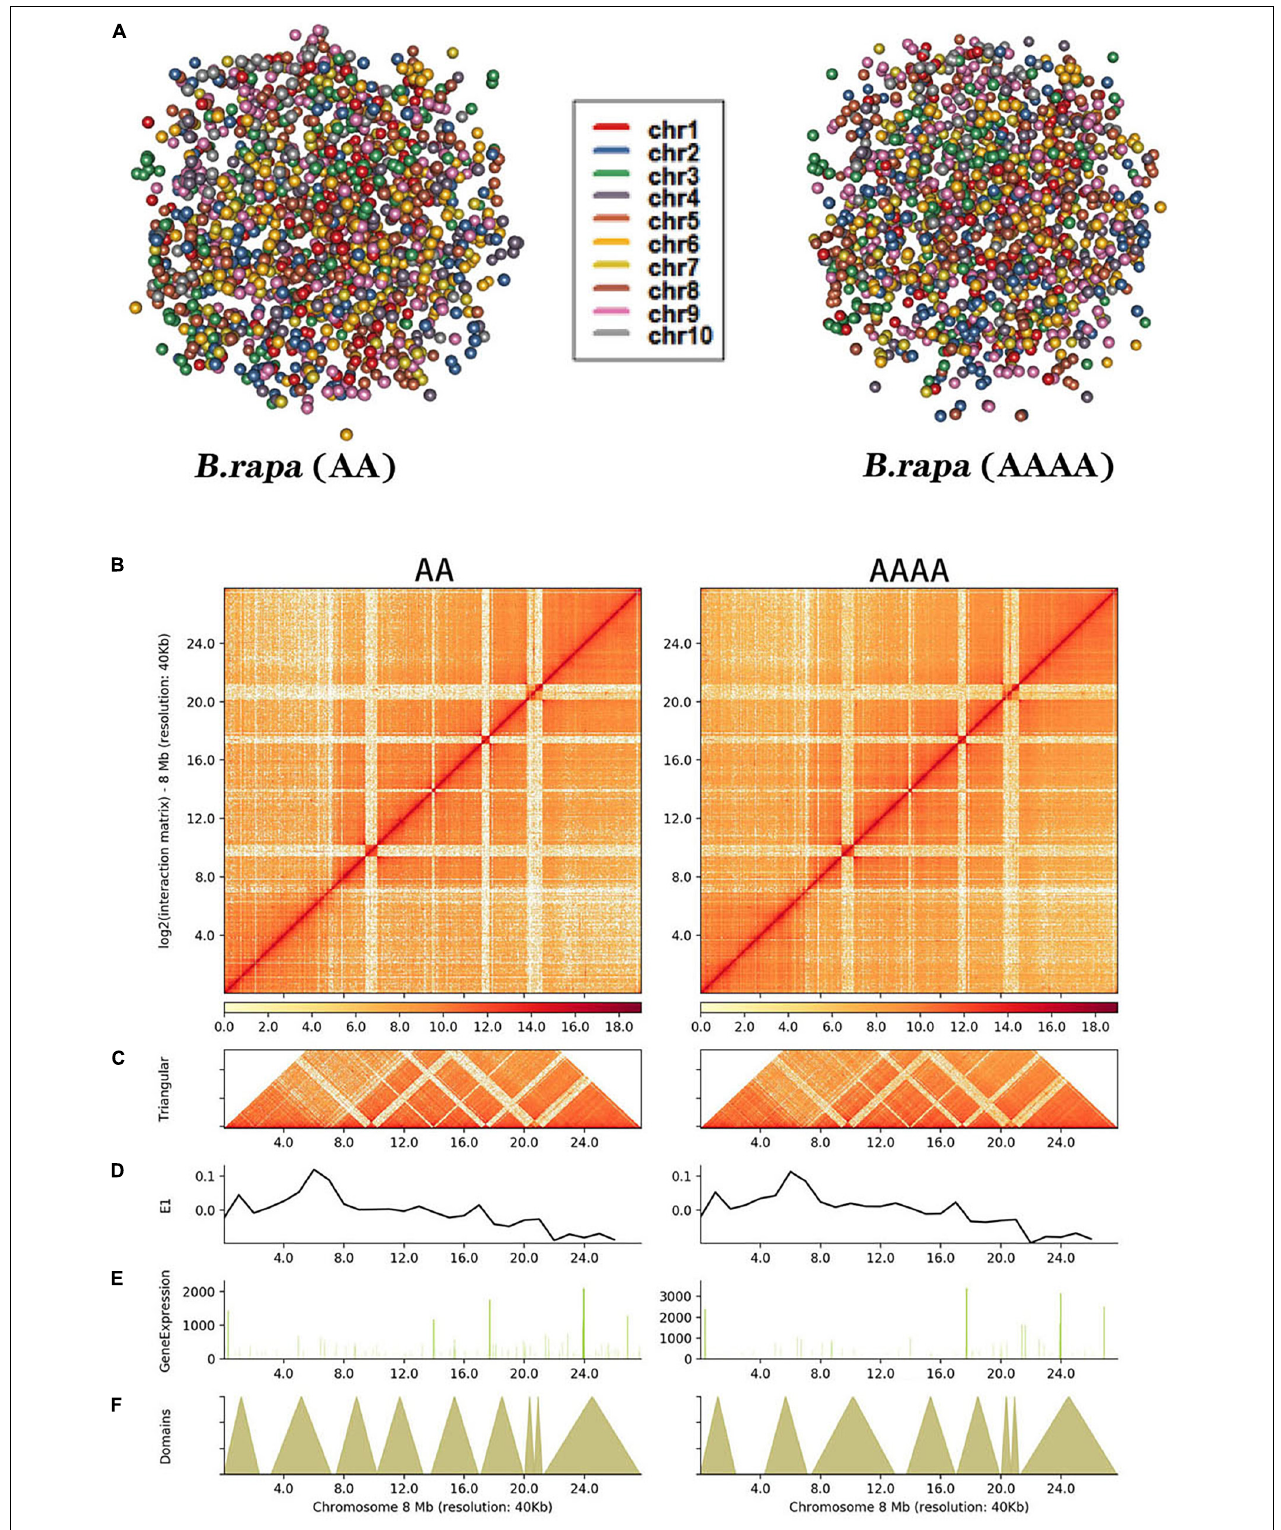
FIGURE 2 | Hi-C analysis of chromatin contacts in diploid and autotetraploid pak choi. (A) 3D model of whole chromosomes. Each chromosome is represented by a different hue. (B) Intrachromosomal interactions of the chromosome at 40 Kb resolution. (C) Each diagonally spread triangle corresponds to a TAD. (D) First principal component values show the type of A/B compartment. (E) Gene expression level based on RNA-seq. (F) Distributions of TADs.